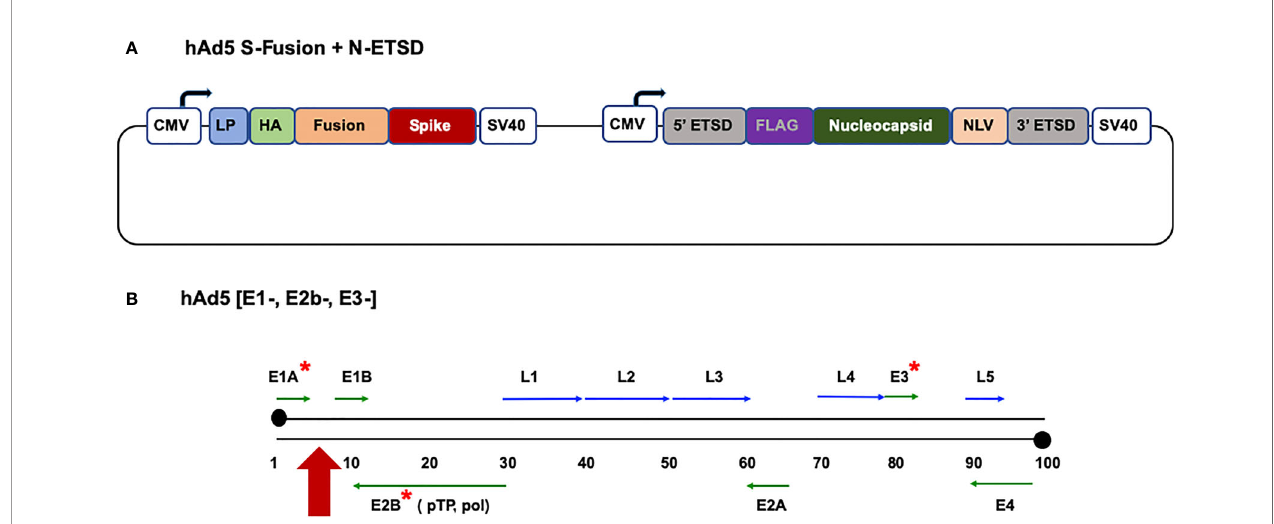
FIGURE 1 | The hAd5 S-Fusion + N-ETSD vaccine and the hAd5 [E1-, E2b-, E3-] platform. (A) The dual-antigen vaccine delivered by the hAd5 [E1-, E2b-, E3-] platform comprises both the spike (S) and nucleocapsid (N) SARS-CoV-2 antigens. The S construct starts with the S leader peptide (LP), followed by human in fl uenza hemagglutinin (HA), a ‘ fusion ’ linker, and the S sequence. The N construct is bracketed by 5 ’ and 3 ’ ETSD sequences and has FLAG, N, and NLV sequences. Expression of both antigens is under control of a cytomegalovirus (CMV) promoter and both end with C-terminal SV40 poly-A sequences. (B) The human adenovirus serotype 5 vaccine platform with E1, E2b, and E3 regions deleted (*) is shown. The vaccine construct is inserted in the E1 regions (red